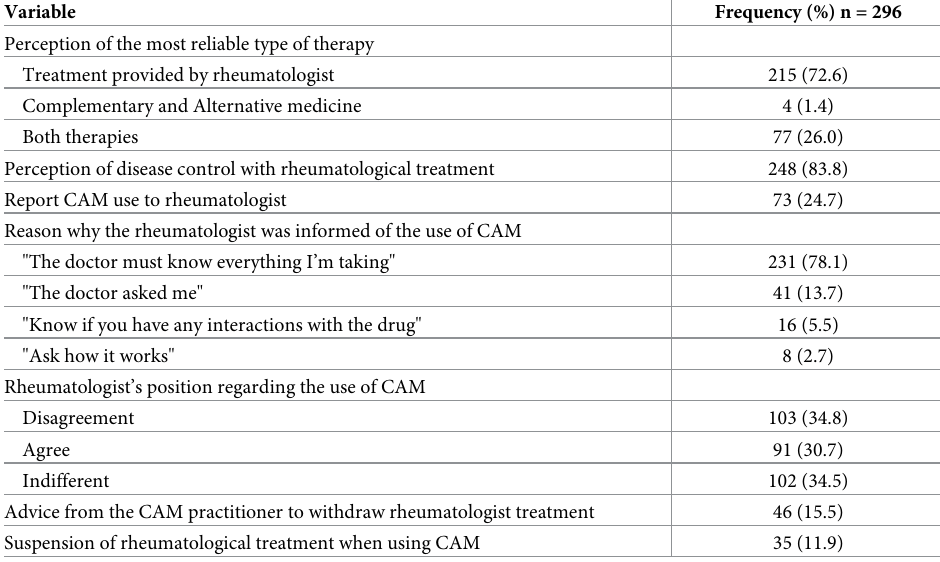
Table 5. Physician related aspects of